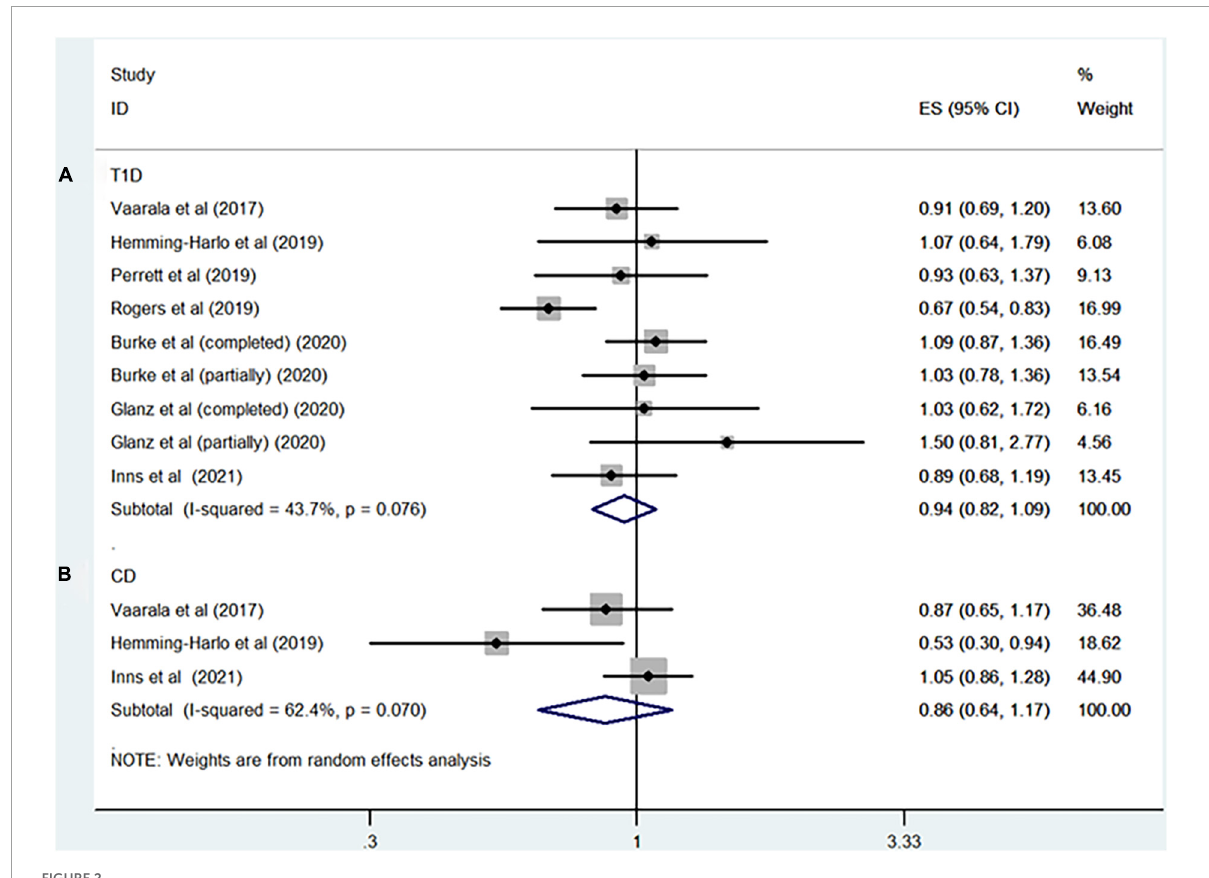
FIGURE2 Rotavirus vaccination exposure and the subsequent risk of (A) T1D and (B)